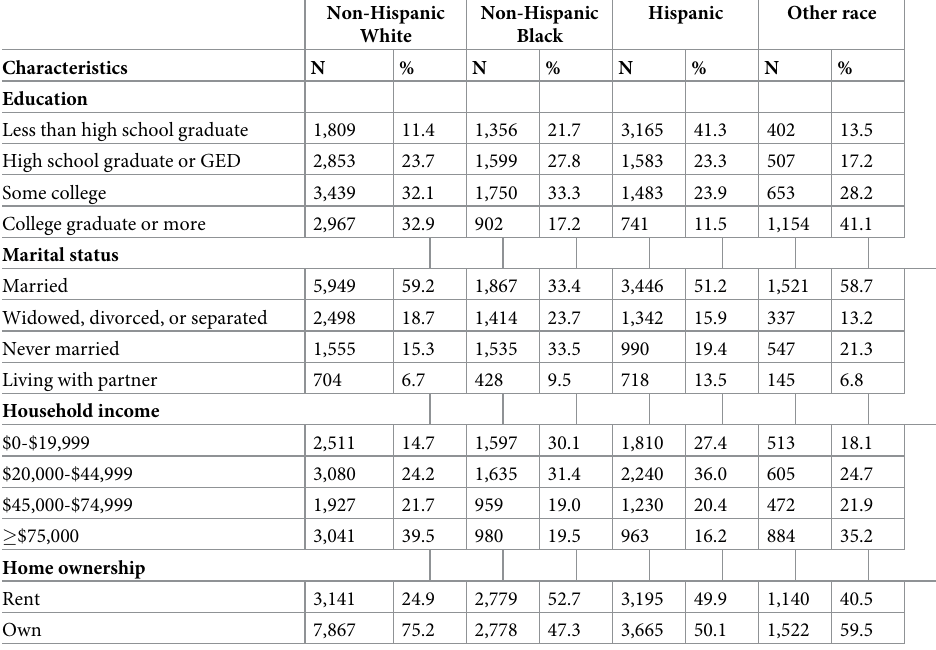
Note: The National Health and Nutrition Examination Survey (NHANES) 2007–2016. Frequencies (N) are unweighted. Percentages (%) are weighted to the U.S. population. Missing values: education (n = 19), marital status (n = 1,386), household income (n = 1,935), home ownership (n = 295). GED is the general education